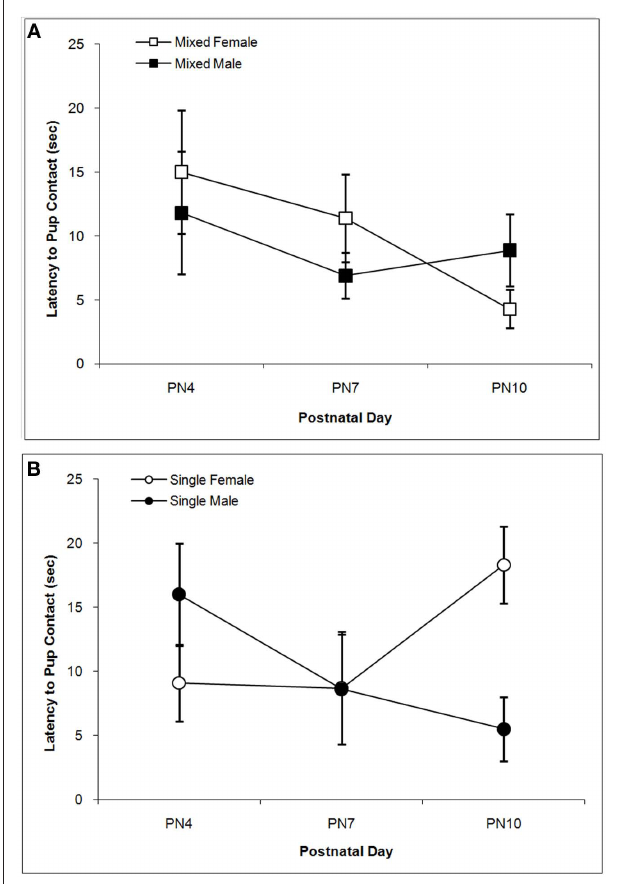
FiguRE 2 | Mean ( ± SEM) latencies (s) for the dam to contact the pup are presented for mixed- [squares; (A)] and single- [circles; (B)] sex litters for male (closed symbols) and female (open symbols) rats over postnatal days. Dams with single-sex litters took longer to contact their male pups on PN4 and their female pups on PN10 relative to other days and to dams of mixed-sex litters. Dams tended to take longer to contact female vs. male pups. See text for